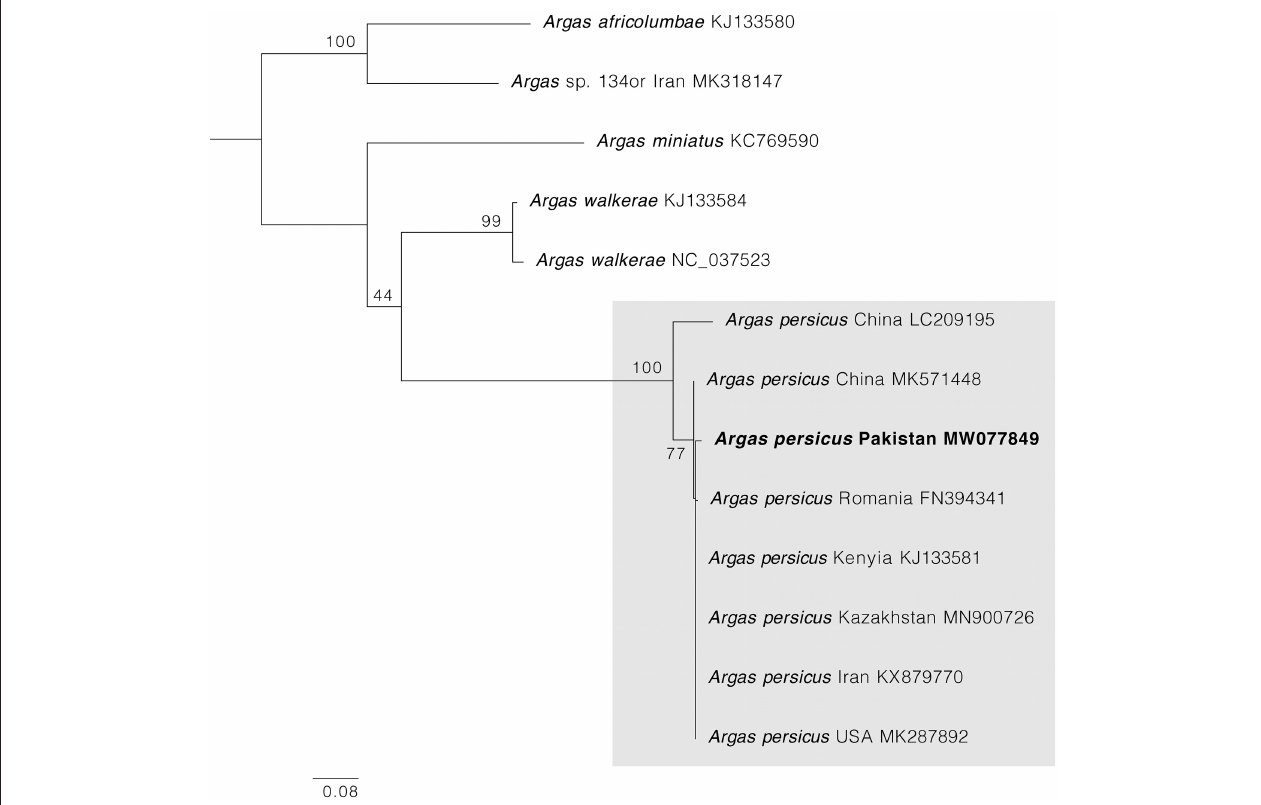
FIGURE 4 | Maximum likelihood tree constructed for the cox1 sequence of A. persicus generated in this study. Species names are followed by country and accession numbers in parentheses. Bootstrapping values (1,000) are shown at each branch. The bar represents 0.08 substitutions per site. Sequence obtained in the present study is highlighted in